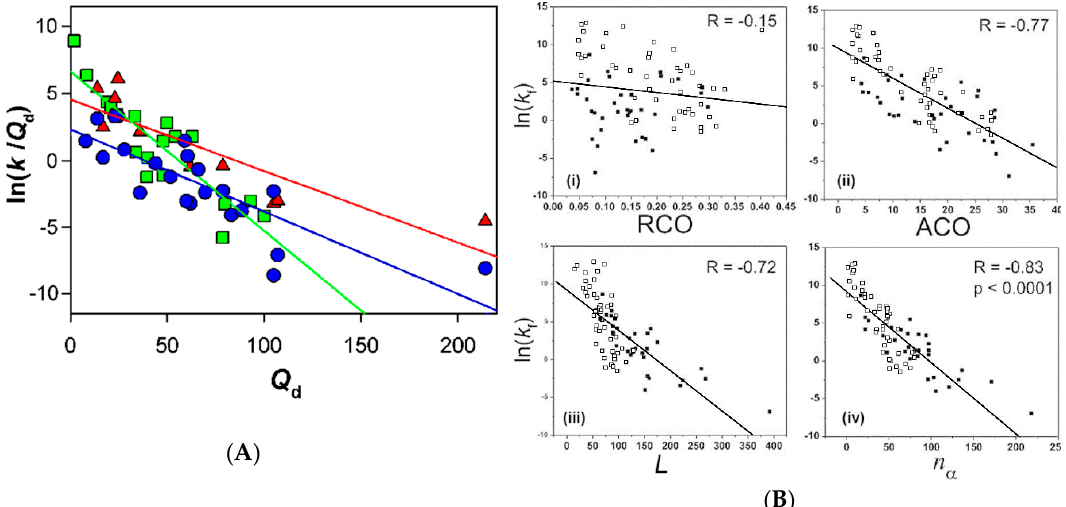
Figure 5. A comparison of the folding rates of two-state and non-two-state proteins. ( A ) The ln( k f / Q d ) and ln( k I / Q d ) values are plotted against Q d . Filled green squares ( ■ ) represent the ln( k f / Q d ) values of two-state proteins. Filled red triangles ( ▲ ) represent the ln( k I / Q d ) values of 10 non-two-state proteins for which the formation of the intermediate was kinetically observed. Filled circles ( ● ) represent the ln( k f / Q d ) values for 22 non-two-state proteins, i.e., the above 10 proteins plus the 12 proteins that show a burst-phase intermediate or only a roll-over in the chevron plot. The green, red, and blue continuous lines represent the best linear fit for ln( k f / Q d ) for the 18 two-state proteins, ln( k I / Q d ) for the 10 non-two-state proteins, and ln( k f / Q d ) for the 22 non-two-state proteins, respectively. Reproduced and modified with permission from [89]. ( B ) Relationship between different structure-based properties and ln( k f ) of two-state (open squares) and non-two-state (filled squares) proteins. (i) Relative contact order, RCO ( R = − 0.15); (ii) absolute contact order, ACO ( R = − 0.77); (iii) chain length, L ( R = − 0.72); and (iv) geometric contact number, n α ( R = − 0.83), where R is the correlation coefficient. Reproduced with permission from [94].